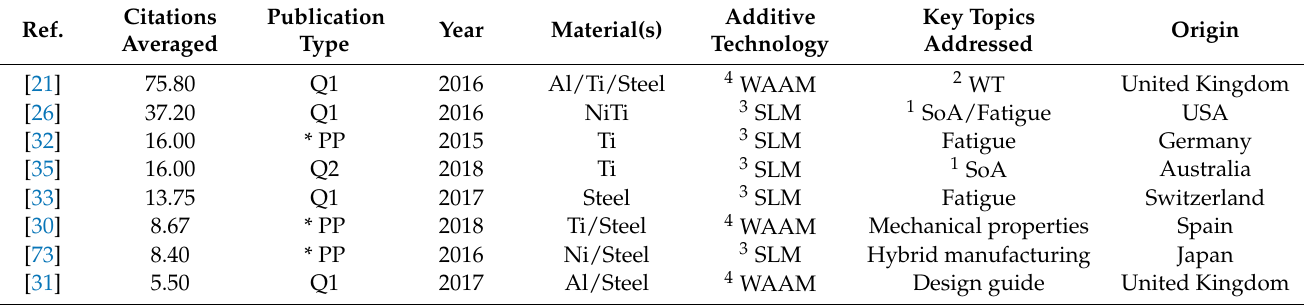
Table 9. Summary of studies including additive manufacturing listed by number of citations, listed by the average number of citations, taking into account the number of years the article has been published.